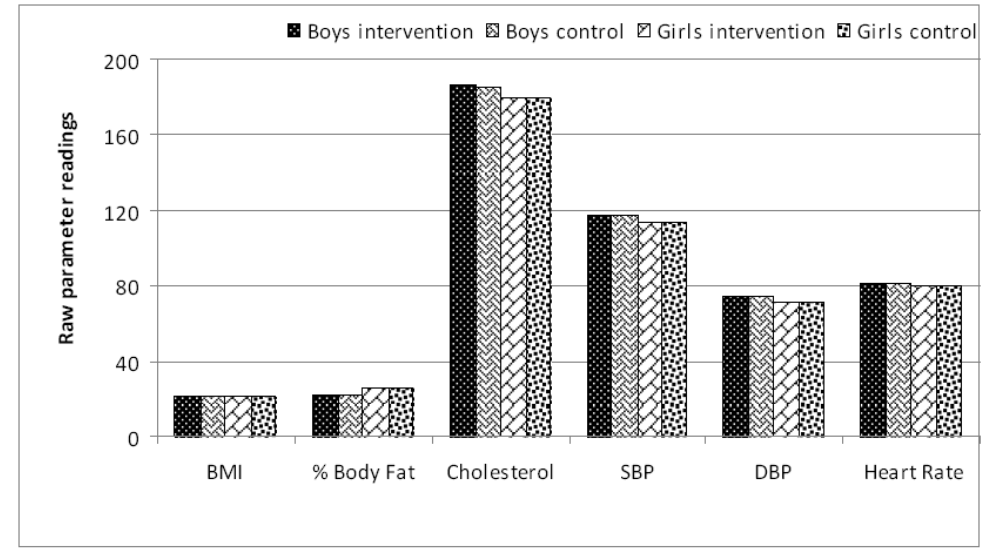
Figure 1. Mean values at baseline by gender: control and intervention